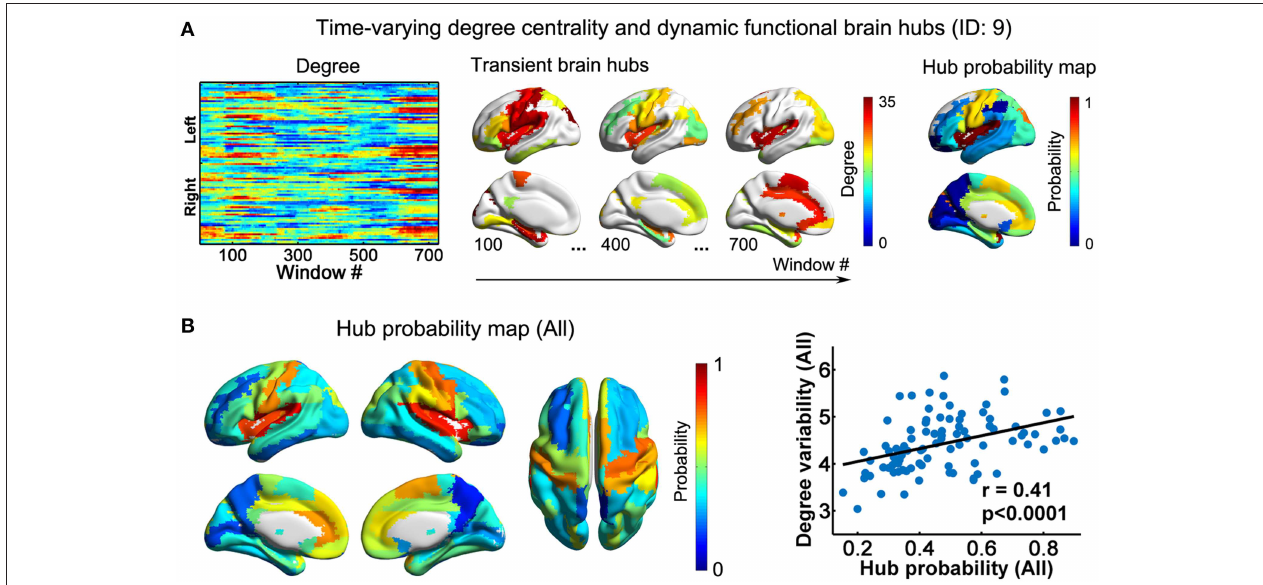
FIGURE 3 | Dynamic functional hubs in the D-FC brain networks. (A) Time-varying degree centrality and dynamic functional brain hubs for one representative participant (ID: 9). Transient brain hubs at several windows (e.g., # = 100, 400, and 700) are displayed. Hub probability map was generated by counting the occurrence probability as hubs across sliding windows for each region. (B) Hub probability map for all participants (left) and scatter plot showing the across-node relationship between hub probability and temporal variability of functional degree centrality (right). The probability map for all participants was generated by averaging individual hub probability maps across participants. The surface-based visualizations were made using BrainNet Viewer (http://www.nitrc.org/projects/bnv/, Xia et al., 2013). D-FC, dynamic functional connectivity.